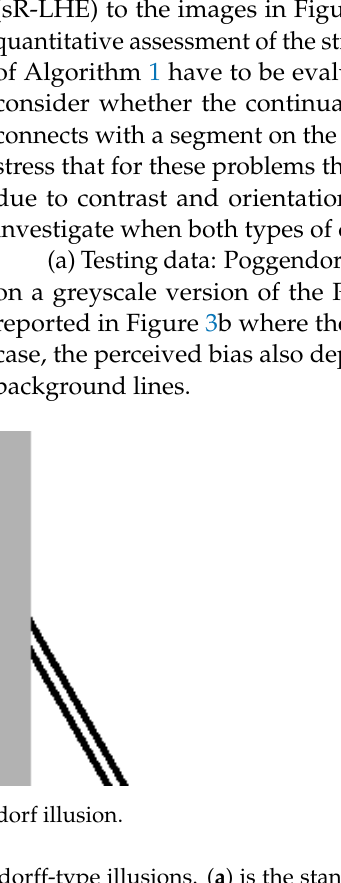
Figure 3. Greyscale Poggendorff-type illusions. ( a ) is the standard 200 × 200 Poggendorff illusion with a 30 pixel-wide central and an incidence angle of π /3 drawn by the black lines with the central bar . ( b ) is a variation of the classical Poggendorff illusion where a further background grating is